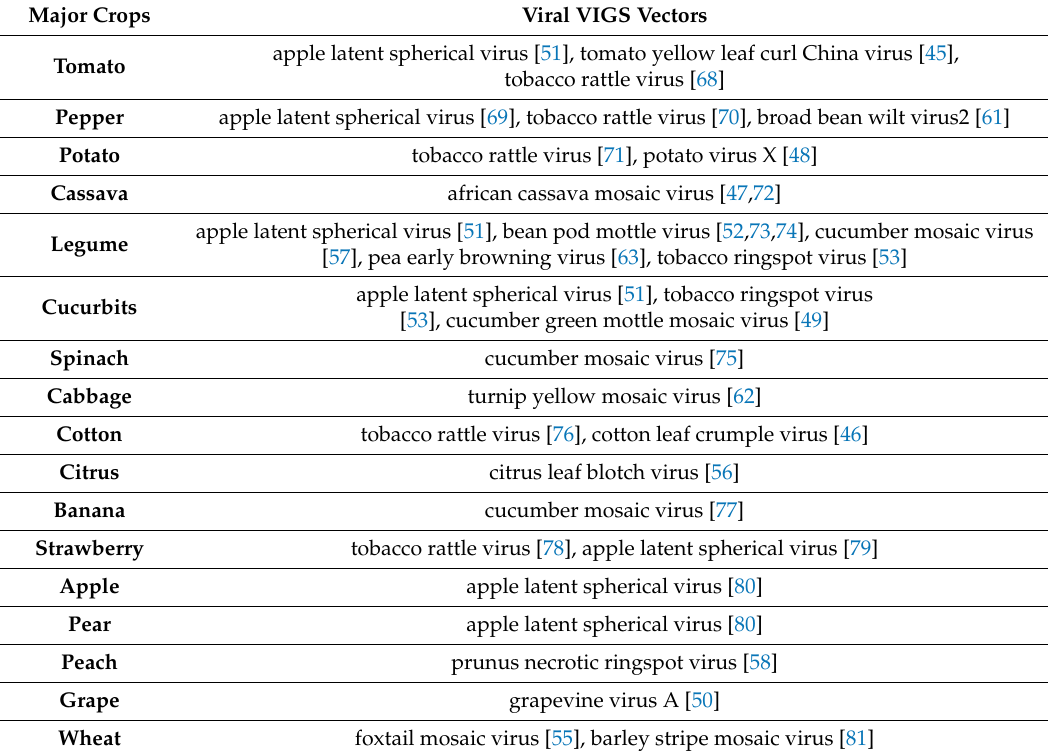
Table 2. Viral VIGS vectors for major